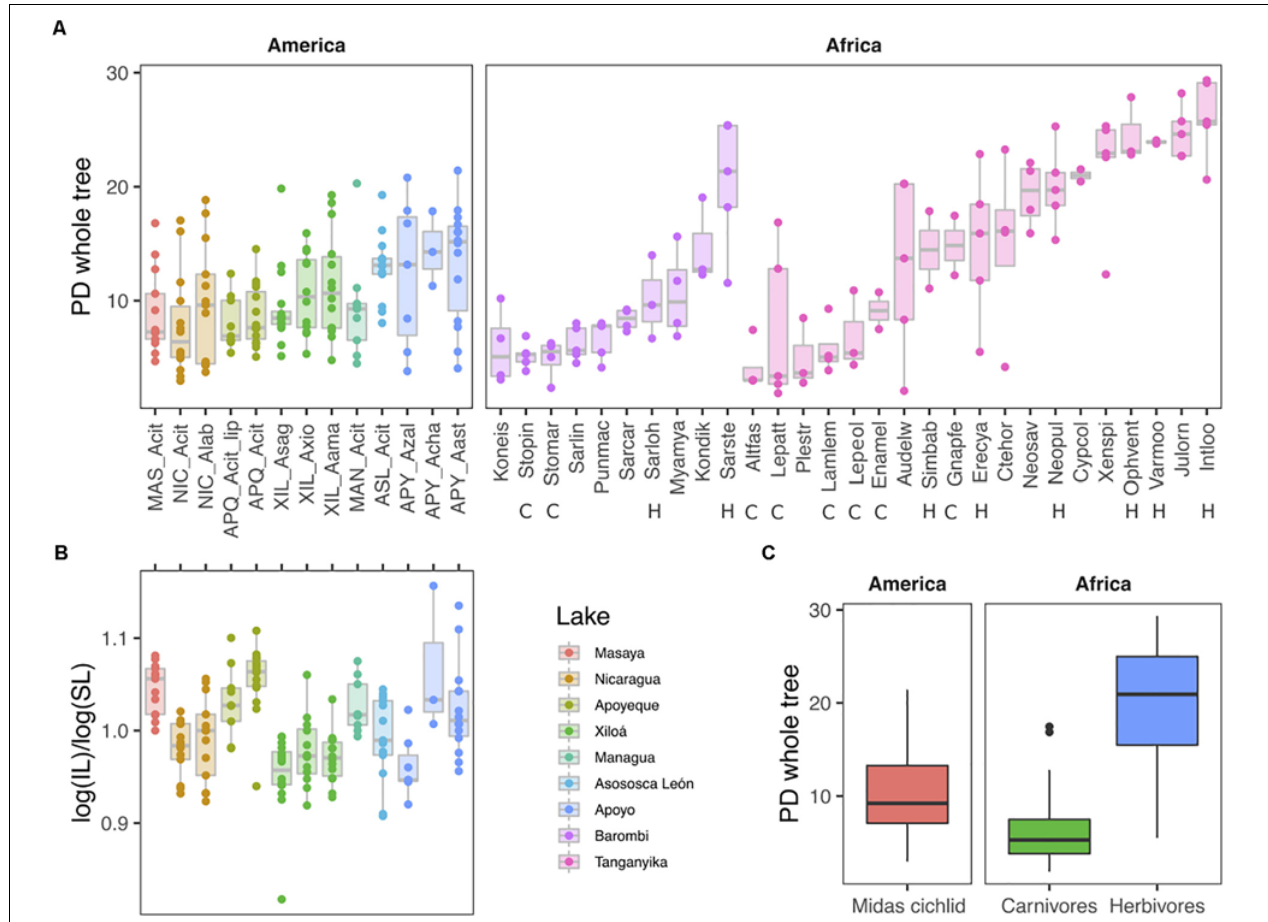
FIGURE 5 | Microbiota Faith’s phylogenetic diversity (PD whole tree) by species (A) and continent (C) and corresponding intestine morphometrics for Midas cichlids only (B) . (C) Overall alpha diversity of Midas cichlids (this study) is intermediate between that of African carnivores (C) and herbivores (H) (dataset from Baldo et al., 2017). Dots represent specimens. IL: Intestine lengths; SL: standard body lengths. NIC: Nicaragua; MAN: Managua; MAS: Masaya; ASL: Asososca León; APQ: Apoyeque; XIL: Xiloá; APY: Apoyo. Acit: A. citrinellus ; Acit_lip: A. citrinellus lipped form; Alab: A. labiatus ; Asag: A. sagittae ; Axio: A. xiloaensis ; Aama: A. Amarillo